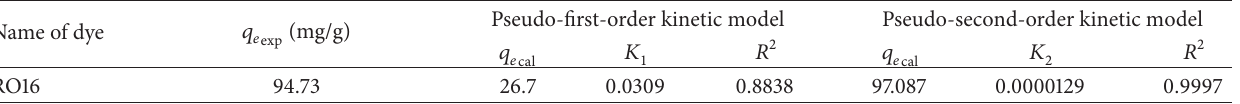
Table 4: Parameters and correlation coefficient ( 𝑅 2 ) of pseudo-first- and pseudo-second-order kinetic model for adsorption of RO16 by MKCF.